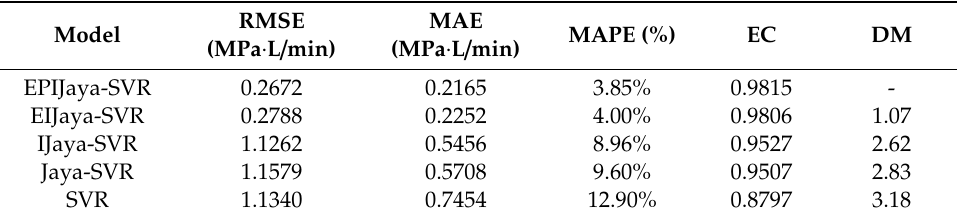
Table 2. The results of evaluation indices and DM test of di ff erent models.